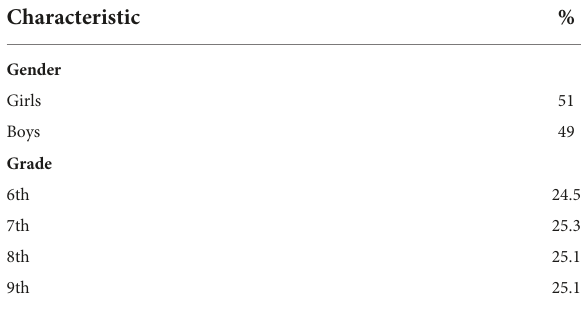
TABLE 1 Students’ characteristics ( N =